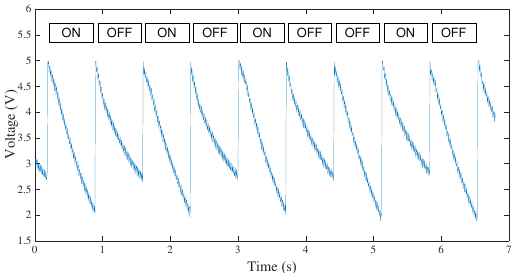
Figure 11. Blue-to-blue link, T = 700 ms.